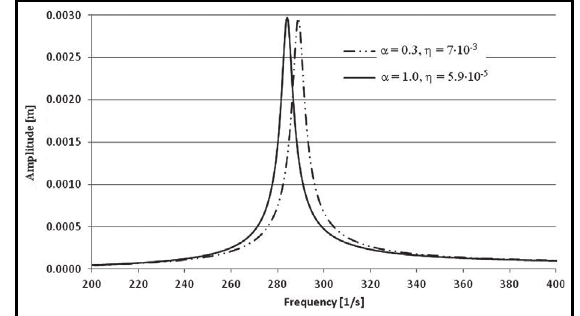
Fig. 10. Comparison of amplitude-frequency characteristics for α = 0.3 η = 7 · 10 − 3 and α = 1.0 η = 5.9 · 10 − 3 .